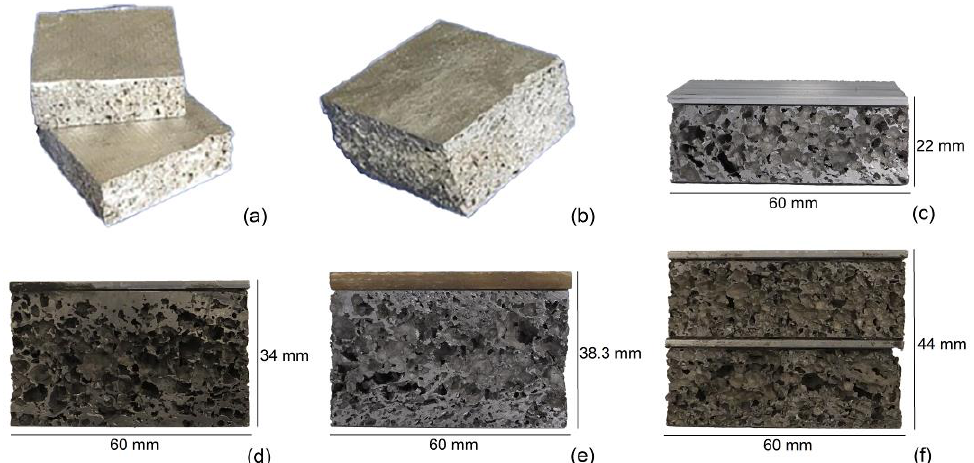
Figure 1. Investigated AF panels: Type I ( a ), Type II ( b ), Type III ( c ), Type IV ( d ), Type V ( e ) and Type VI ( f ).